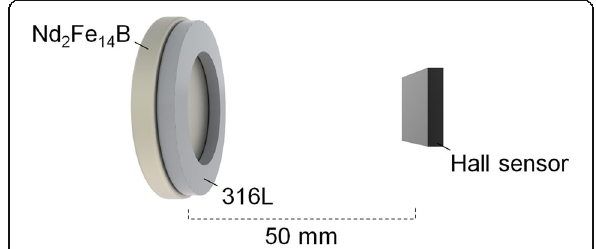
Fig. 6 Open circuit magnetic flux measurement of the hybrid material systems by a hall